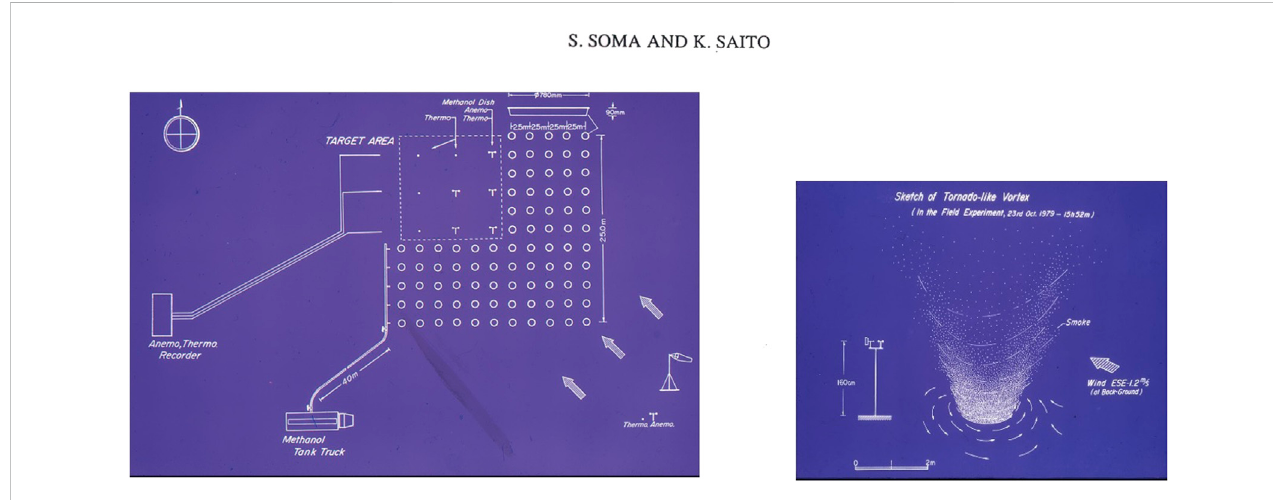
FIGURE 6 Schematic of 1/100 scale model outdoor fi re whirl experiment and type 3 fi re whirl.